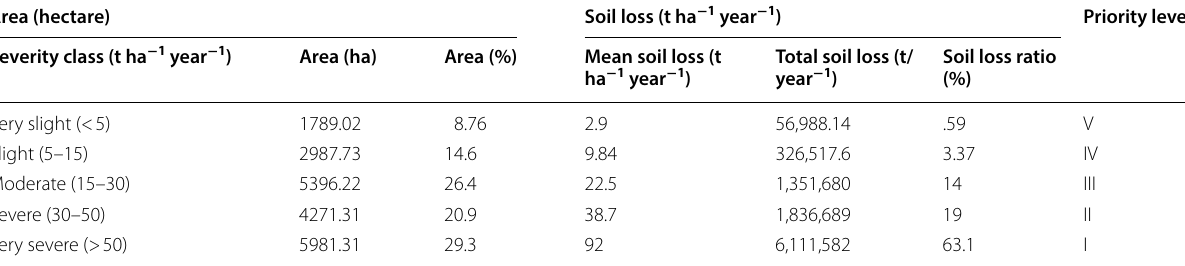
Table 8 Severity classes adopted from Haregeweyn et al. (2017), its area coverage, soil loss and priority levels Area